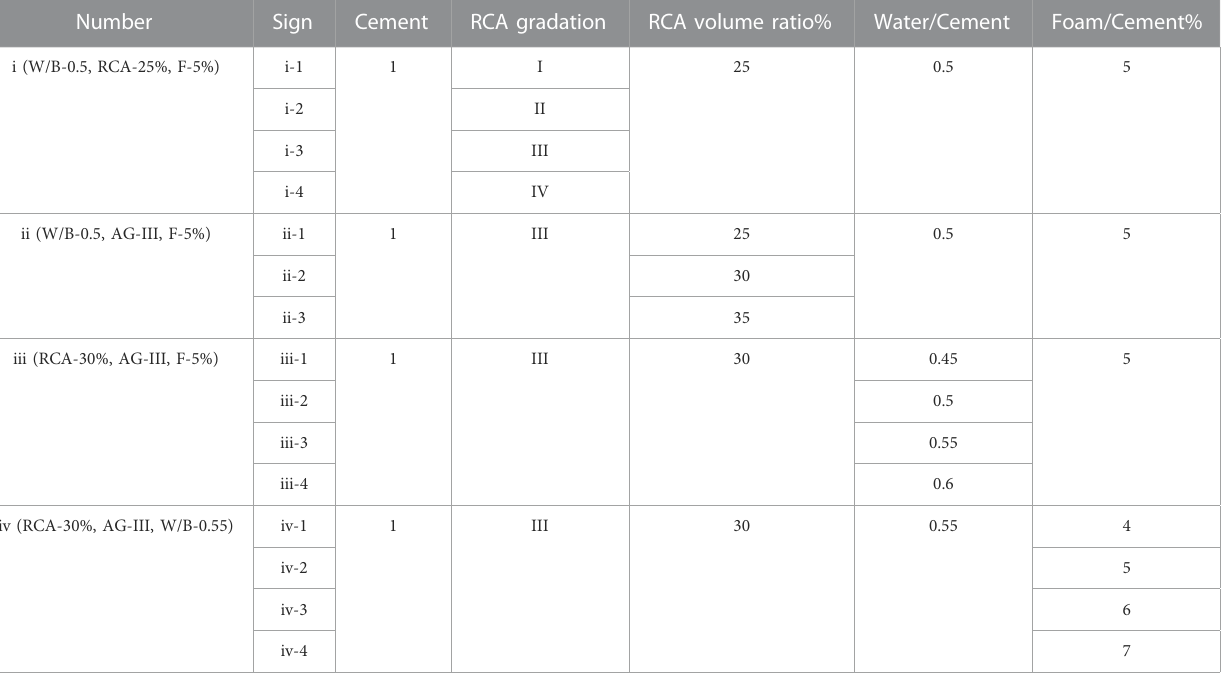
TABLE 3 Mix proportion of